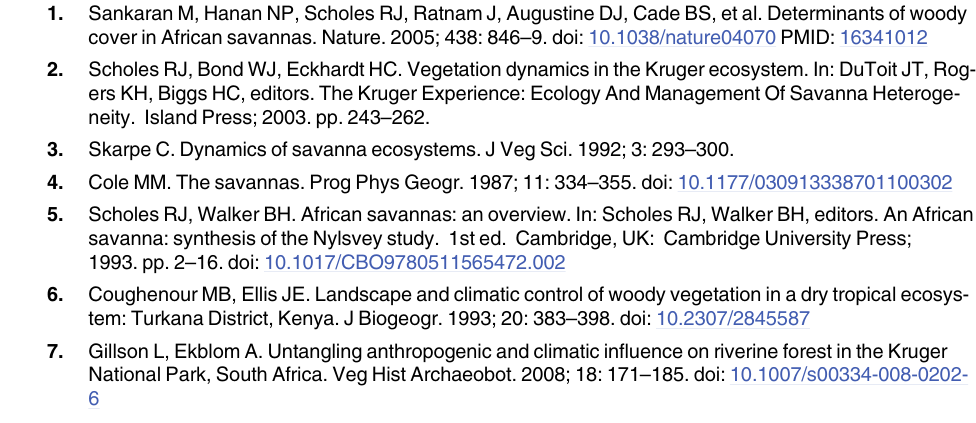
(shrub), 2.5 to 5.0 m (small tree), 5.0 to 10.0 m (medium tree), and > 10.0 m (large tree). S2 Fig. Importance of individual environmental factors to the models. Factor importance, quantified using the difference in R 2 values between the full model and the model without the indicated variable (and its associated interaction terms), for each watershed and response vari- able. Listed variables are: slope (SLP), aspect (ASP), relative slope position (RSP), distance to order 1,2 and 3 stream (DO1, DO2, and DO3), fire return interval (FRI), fire wait time (FWT), topographic wetness (WET), and soil type (STP, available only on the southern granite site). Proportion vegetation is defined as the proportion of area in a 16.8 x 16.8 m window of the veg- etation height map that is in the given height class: 0.5 to 2.5 m (shrub), 2.5 to 5.0 m (small tree), 5.0 to 10.0 m (medium tree), and > 10.0 m (large tree). S1 File. Sample point data used in the analyses described in the manuscript. S1 Table. Environmental traits of the four focal